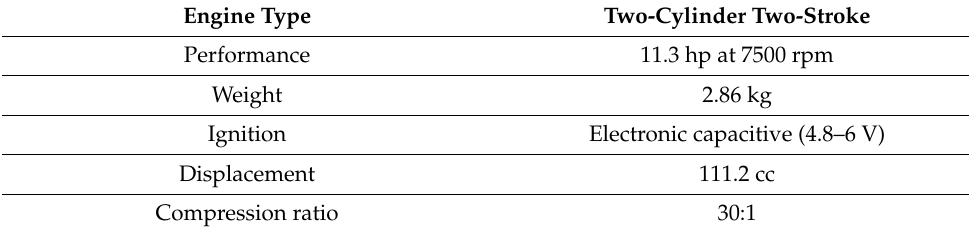
Figure 9. DLE-111™ ICU. Table 4. ICU specifications.